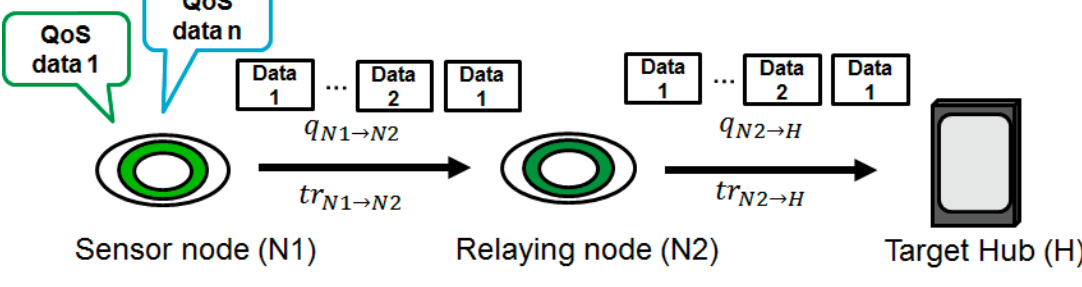
Figure 6. System Figure 6. System model. Figure 6. System model.